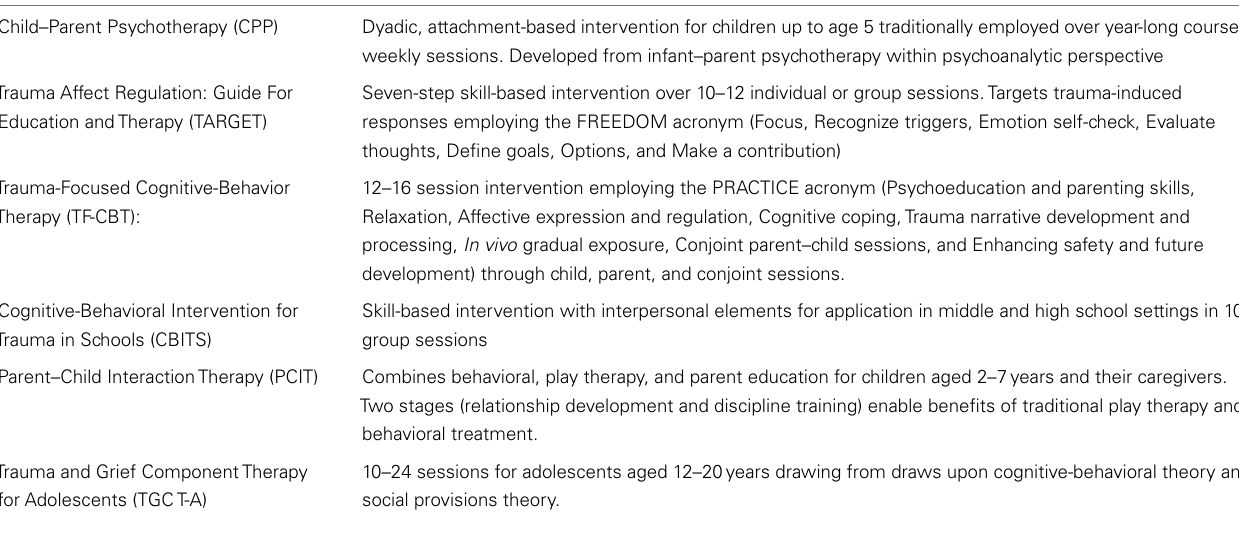
Table 1 | Interventions for childhood trauma rated as either effective or promising (32)